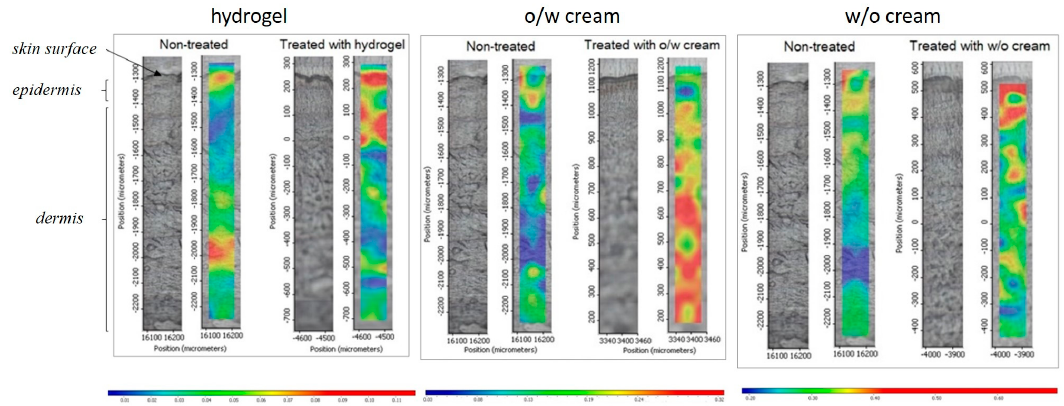
Figure 3. Raman correlation maps for the distribution of diclofenac sodium in human skin specimens after treatment with hydrogel, o / w cream and w / o cream. Untreated skin is also displayed as a control in all cases. Color coding of drug formulation content: red > yellow > green > blue.